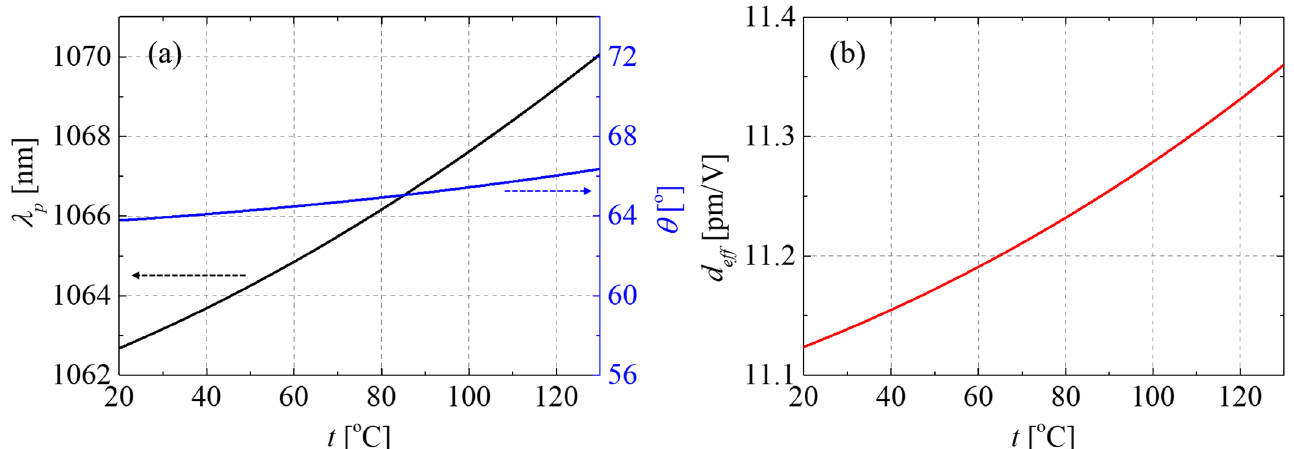
Figure 4. For the case with the largest d eff value (i.e., ϕ = 0) under Type II EPM, the temperature dependence of: ( a ) the λ p resonance and the corresponding polar angle ( θ ) and ( b ) the d eff values plotted as a function of t . Table 2. For the case with the maximum d eff value, the Type II EPM conditions where the reso- nance of the pump photon is located at the center wavelength of Nd:YAG lasers (i.e., 1064 nm). Physical Quantities